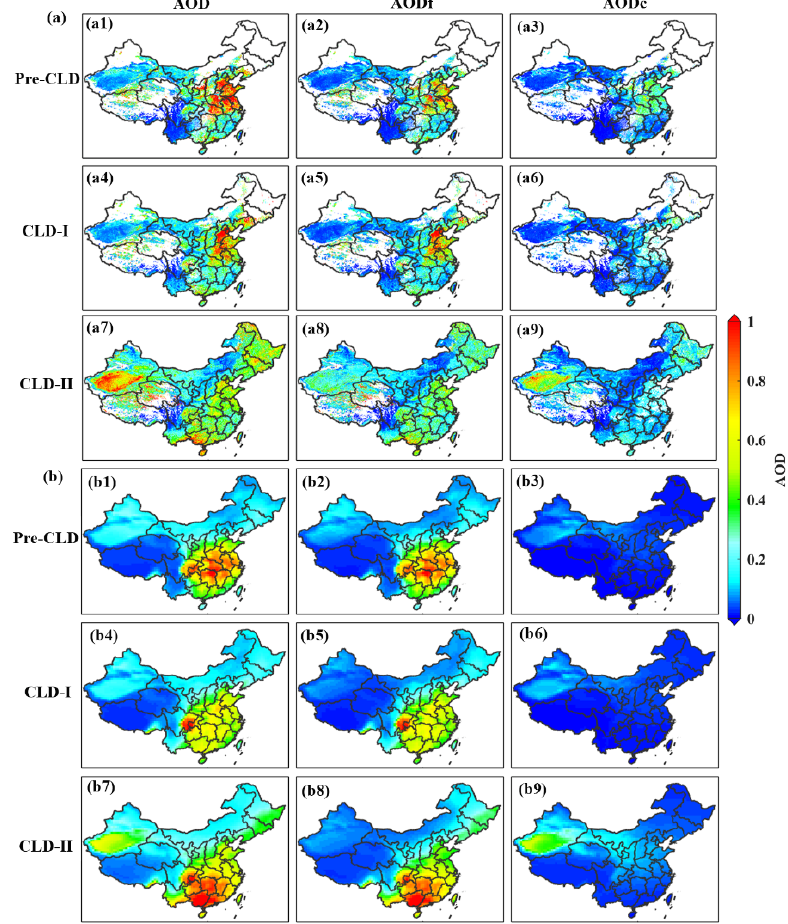
Figure 2. ( a ) Spatiotemporal distribution of AOD, AODf, and AODc at 550 nm from MODIS during the Pre-CLD ( a1 – a3 ), CLD-I ( a4 – a6 ), and CLD-II ( a7 – a9 ) periods. ( b ) MERRA-2 provides the AOD, AODf, and AODc at 550 nm during the Pre-CLD ( b1 – b3 ), CLD-I ( b4 – b6 ), and CLD-II ( b7 – b9 ) periods. The study area’s boundaries and the locations of critical cities were displayed in Figure 1. Table 2. Statistical analyses of AOD, AODf, and AODc from MODIS and AAOD (MERRA-2)